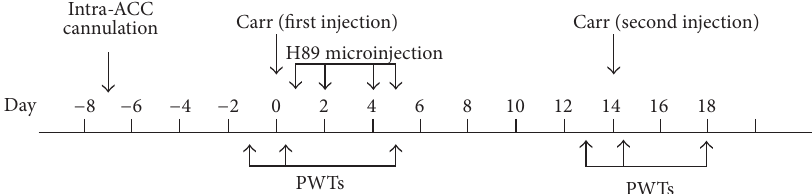
Figure 2: Flow chart of the PKA inhibitor intervention and PWTs detection in different time points. Before the establishment of pain memory model, intra-ACC cannulation was implanted. H89 microinjection was administered at 5 h and 1–5d continually. The PWTs at days − 1, 0, and 5 in the first injection time and days 13, 14, and 18 in the second injection time were recorded to evaluate pain.